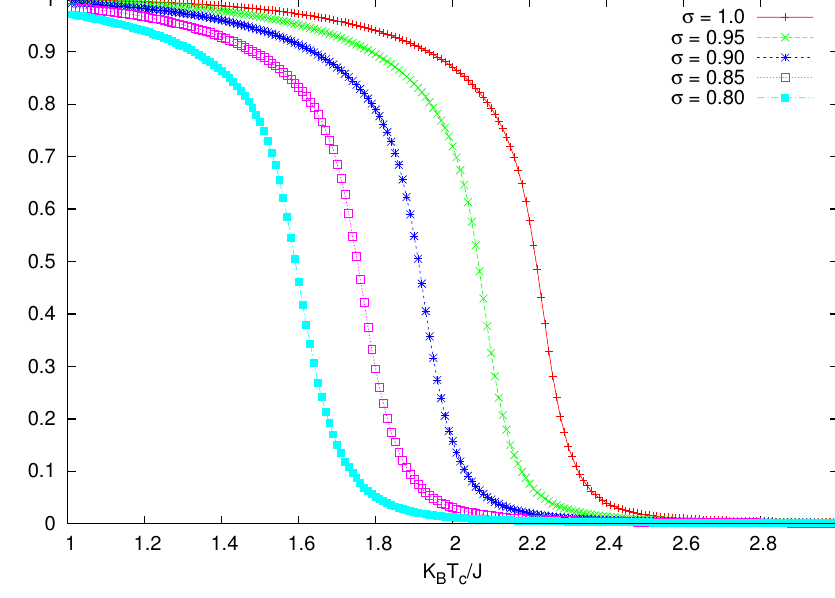
Fig. 1. The absolute magnetization | M | as a function of the temperature